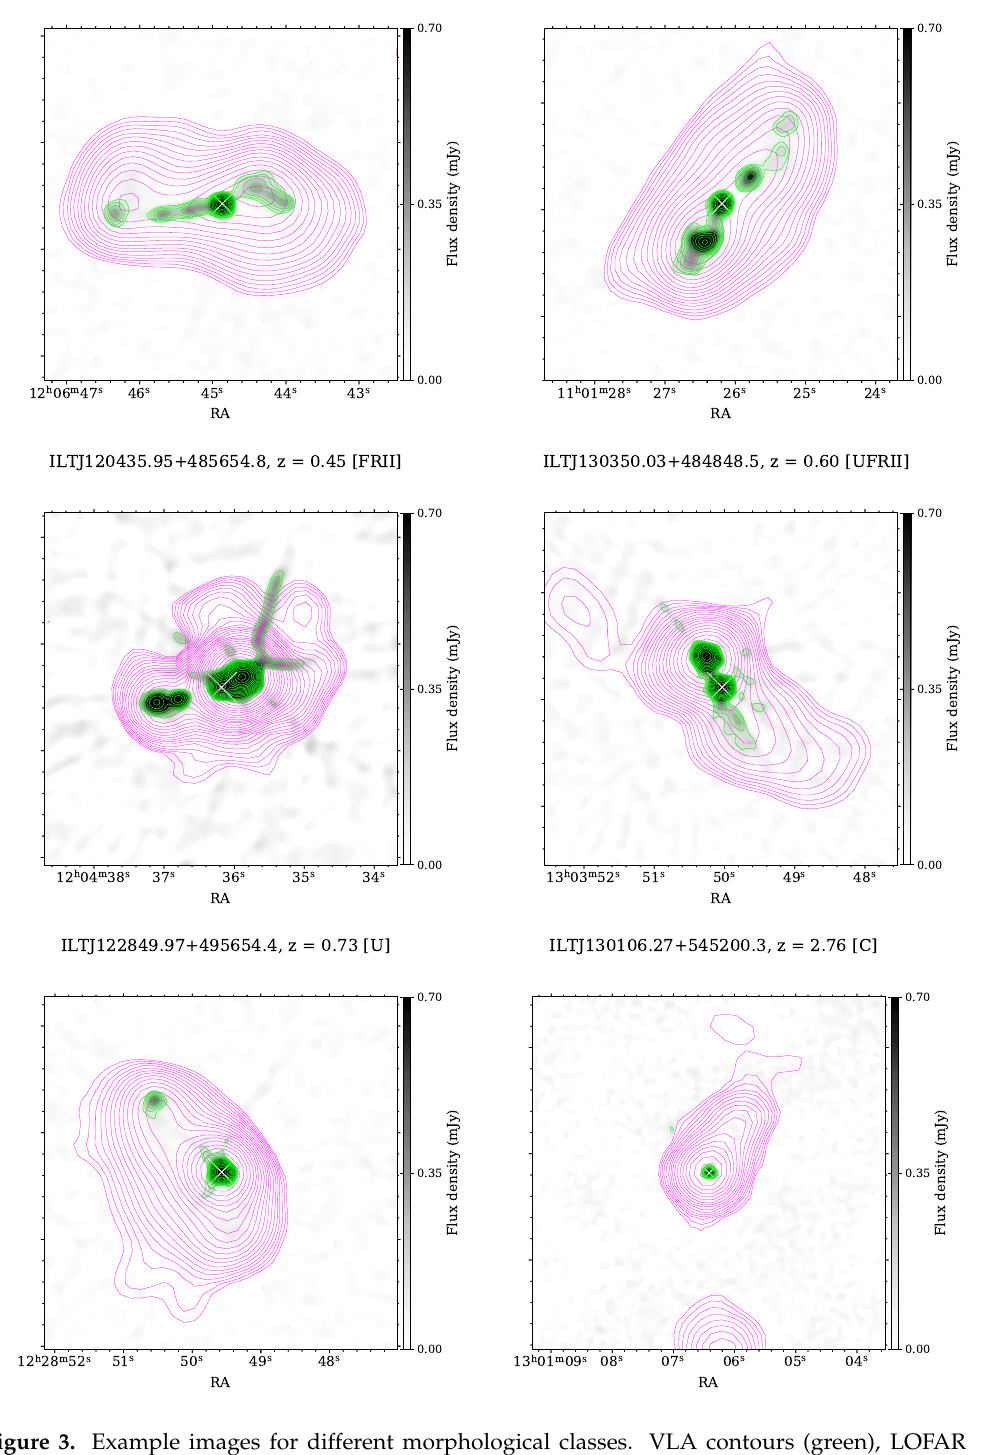
Figure 3. Example images for different morphological classes. VLA contours (green), LOFAR contours (magenta) on VLA images (gray). UFRI: uncertain FRI, UFRII: uncertain FRII, U: uncertain, C: core-dominated The LOFAR and VLA contours denote the surface brightness levels starting at 3 σ and increasing at various powers of 3 σ , where σ denotes the local root-mean-square (RMS)